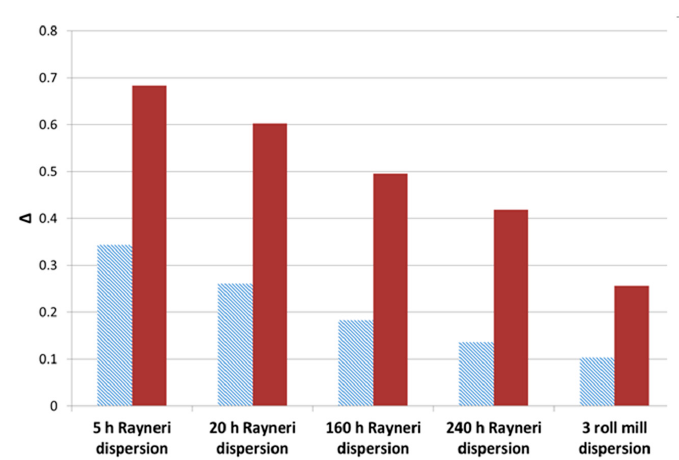
Figure 2. Evolution of storage modulus (G’) as a function of frequency, 0.1% of dynamic strain at 25 °C, for diglycidyl ether of Bisphenol A (DGEBA)/multiwall carbon nanotube (MWNT) suspensions (1 wt %) with different mixing conditions.